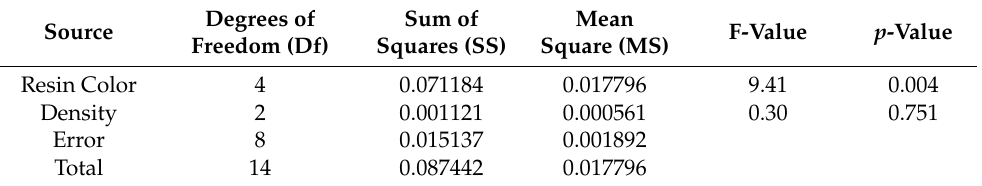
Table 5. Analysis of variance for width